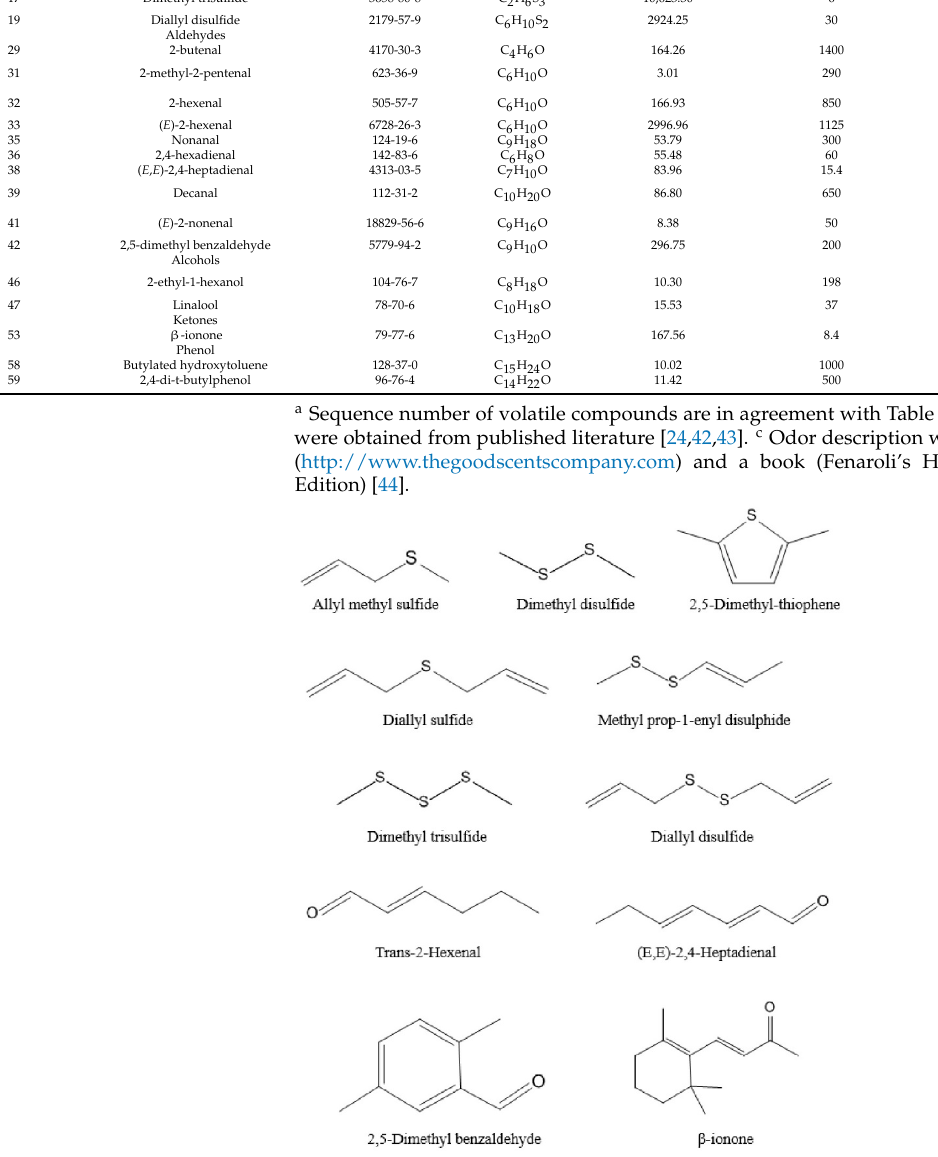
Figure 3. The 11 major aroma-active compounds identified by OAV calculations in Chinese chive.